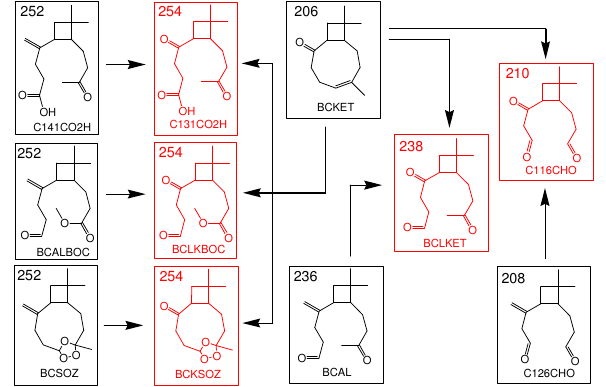
Figure 6. Simplified schematic of ozonolysis conversion routes for selected first-generation products (shown in black) to selected second-generation products (shown in red). With the exception of BCKET, all processes represent the partial formation of a second-generation carbonyl product from ozonolysis of the residual “exocyclic” double bond in the corresponding first-generation product. In the case of BCKET, the schematic shows the formation of the same series of second-generation products following ozonolysis of the residual endocyclic bond. The displayed values indicate the molecular masses of the products.